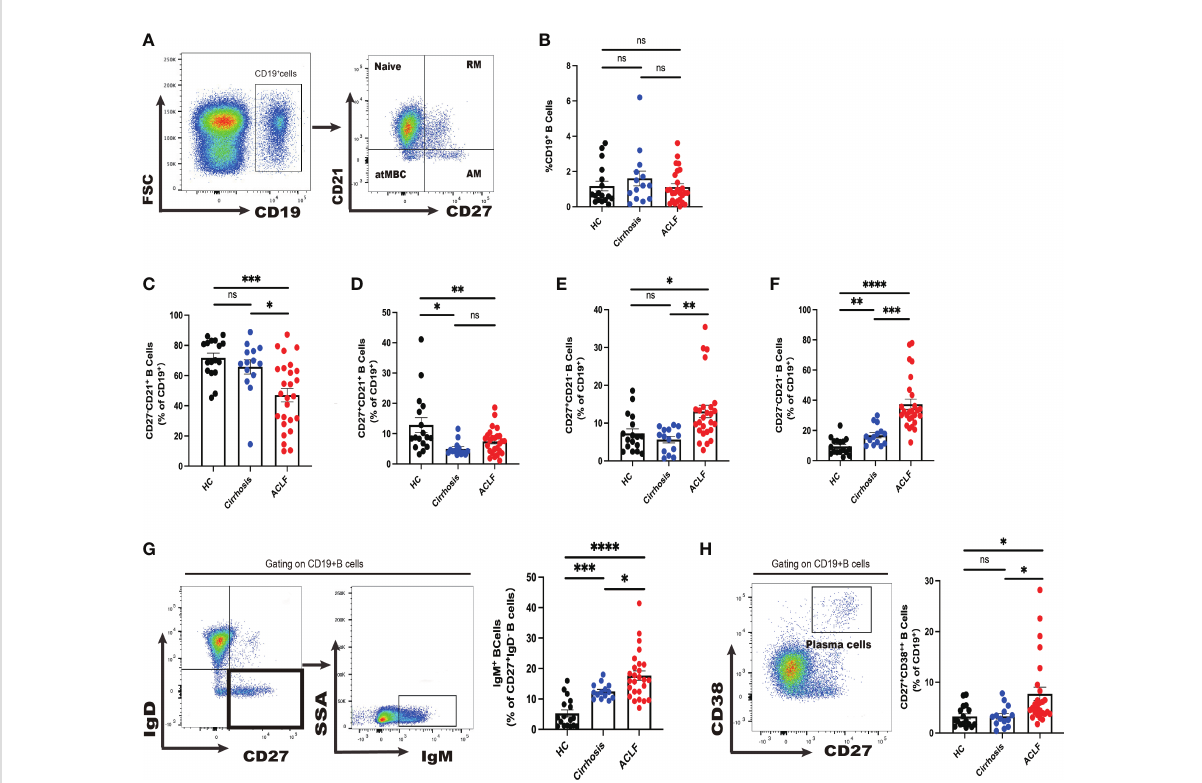
FIGURE 1 Divergent peripheral B-cell subsets in ACLF, cirrhosis, and HC. (A, B) The gating strategy of analysis of CD19 + B cells by fl ow cytometry and the ratio of CD19 + B cells in blood (HC, n = 17; cirrhosis, n = 14; ACLF, n = 26). (C – F) The ratio of CD27 − CD21 + CD19 + B cells, CD27 + CD21 + CD19+ B cells, CD27 + CD21 − CD19 + B cells, and CD27 − CD21 − CD19 + B cells in blood (HC, n = 17; cirrhosis, n = 14; ACLF, n = 26). (G) The gating strategy for grouping blood CD19 + B cells into IgD − IgM + subset by fl ow cytometry and the ratio of IgD − IgM + CD19 + B cells in blood (HC, n = 17; cirrhosis, n = 14; ACLF, n = 26). (H) The gating strategy for grouping blood CD19 + B cells into CD27 + CD38 ++ subset by fl ow cytometry and the ratio of CD27 + CD38 ++ CD19 + B cells in blood (HC, n = 17; cirrhosis, n = 14; ACLF, n = 26). *p < 0.05, **p < 0.01, ***p < 0.001, and ****p < 0.0001; ns, not signi fi